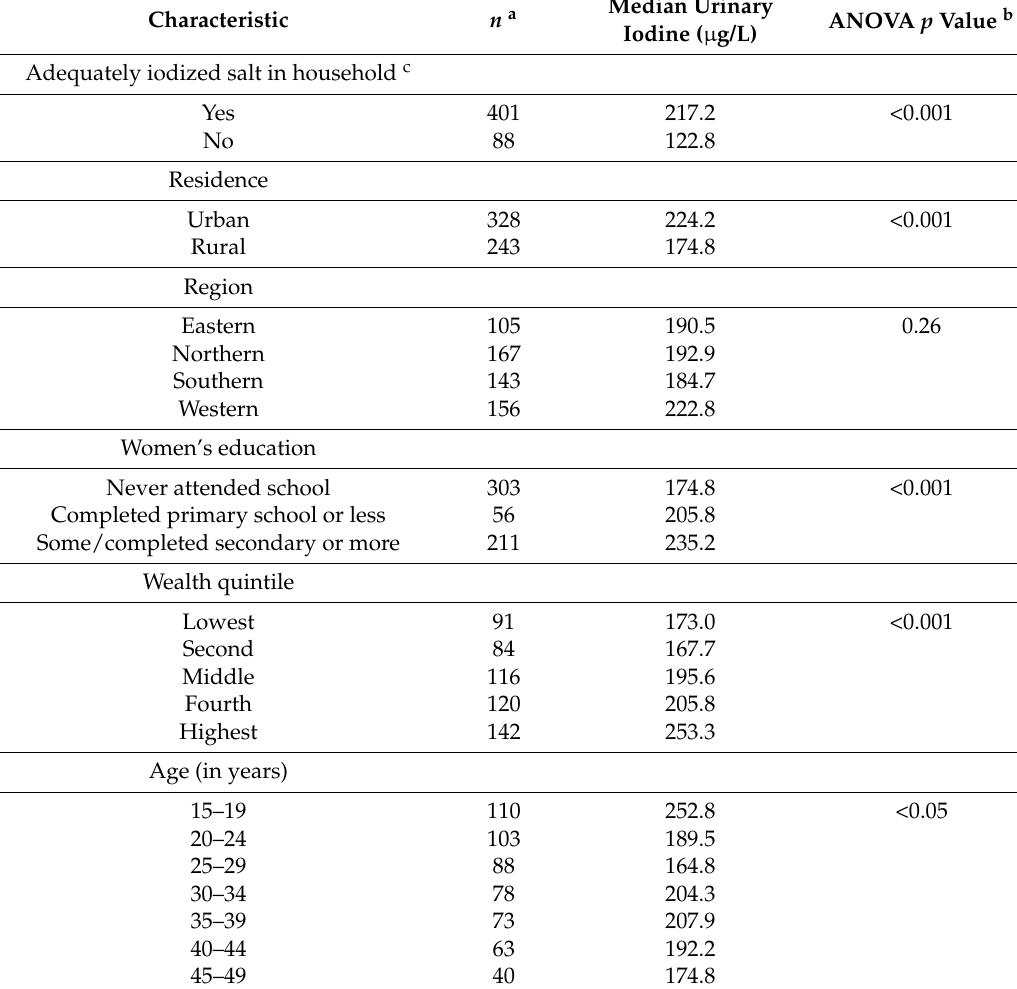
Median Urinary ANOVA p Value b Iodine ( µ g/L)